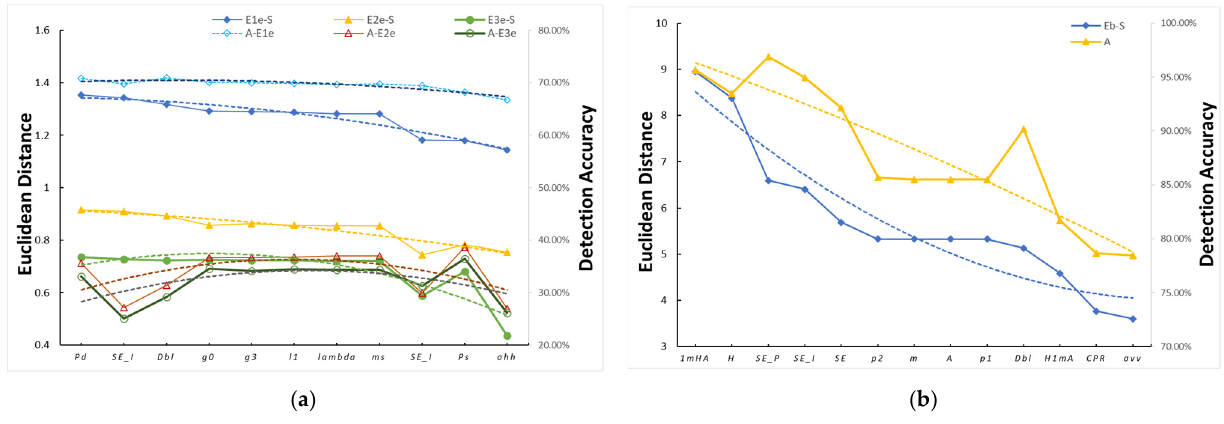
Figure 12. Euclidean distance and eddy detection accuracy of CP features with better eddy detection performance. ( a ) W-E, where E1e-S , E1e-S , and E1e-S are the Euclidean distances between the edge regions of eddies E-1 , E-2 , and E-3 and seawater, respectively. A-E1e indicates the detection accuracy of E1e . ( b ) B-E, where Eb-S is the Euclidean distance between the black spiral of the eddy and the seawater. The colored dashed lines are the results of the third-order polynomial fit. The line marked “A” indicates the eddy detection accuracy.